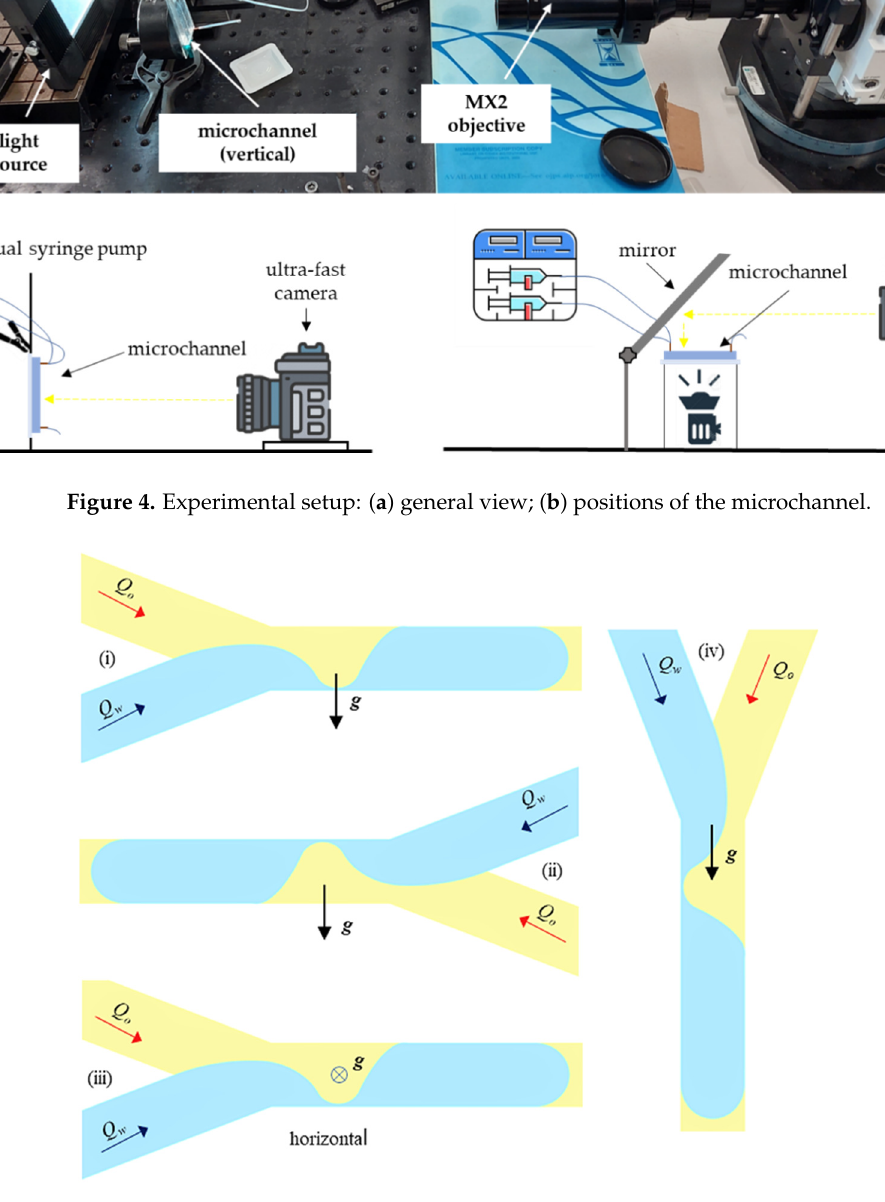
Figure 6. Interface dynamics and water-droplet formation in oil for one cycle; series of images cap- tured from video recordings at 1000 fps: from droplet detachment ( f , a ) to the interface rupture ( e ). ( a ) previous droplet marked in red circle; ( b ) water advancement; ( c ) neck formation; ( d ) neck thin- ning; ( e ) neck before interface rupture; ( f ) droplet after interface rupture.